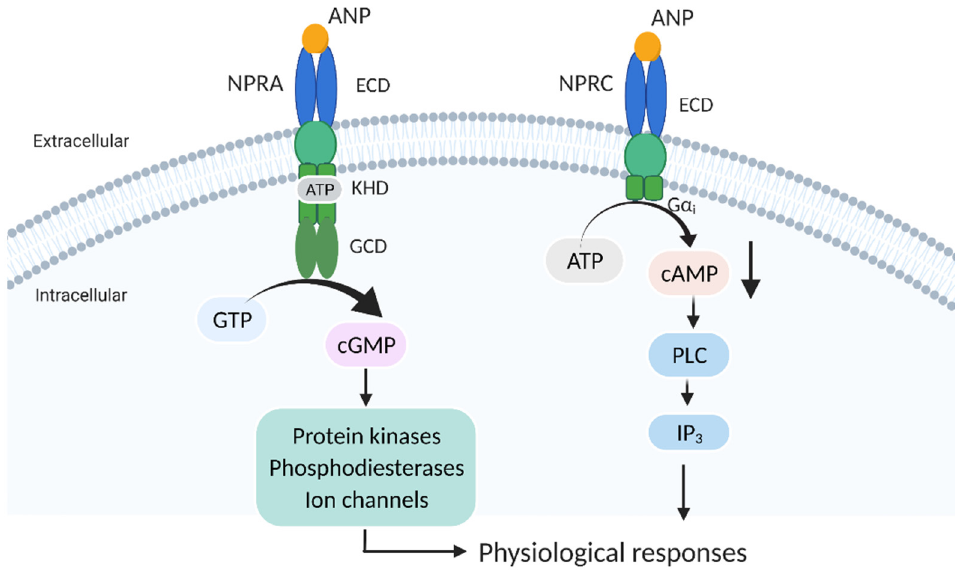
Figure 2. Diagram representing the downstream effects of ANPs and NPRs. ANPs bind to the extracellular ligand-binding domain (ECD) of NPRA, causing conformational change and phosphorylation of the intracellular protein-kinase homology domain (KHD), which then stimulates the guanylate cyclase catalytic domain (GCD) to convert GTP into cGMP, while the production of cGMP activates downstream effectors, such as protein kinases. ANPs bind to the ECD of NPRC to activate the inhibitory guanine nucleotide regulatory protein activator (G α i) domain, thereby inhibiting adenylate cyclase activity and activating phospholipase C (PLC).